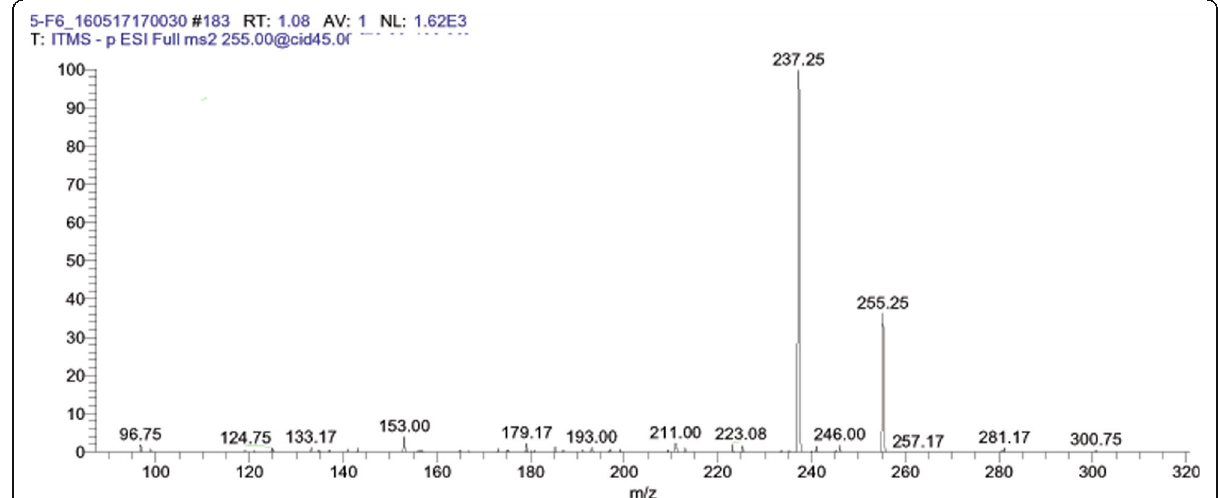
Fig. 3 LC MS/MS Chromatogram of fraction 2 (F2) from ethanol extracts of Glycyrrhiza glabra showing